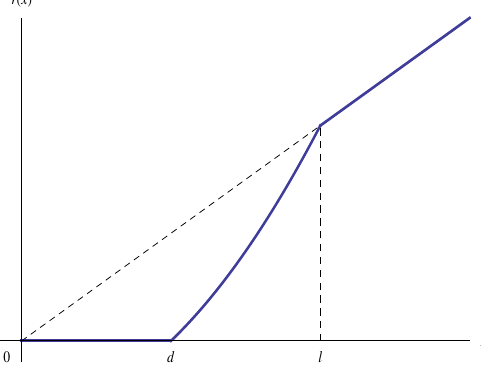
Figure 1. A disappearing deductible